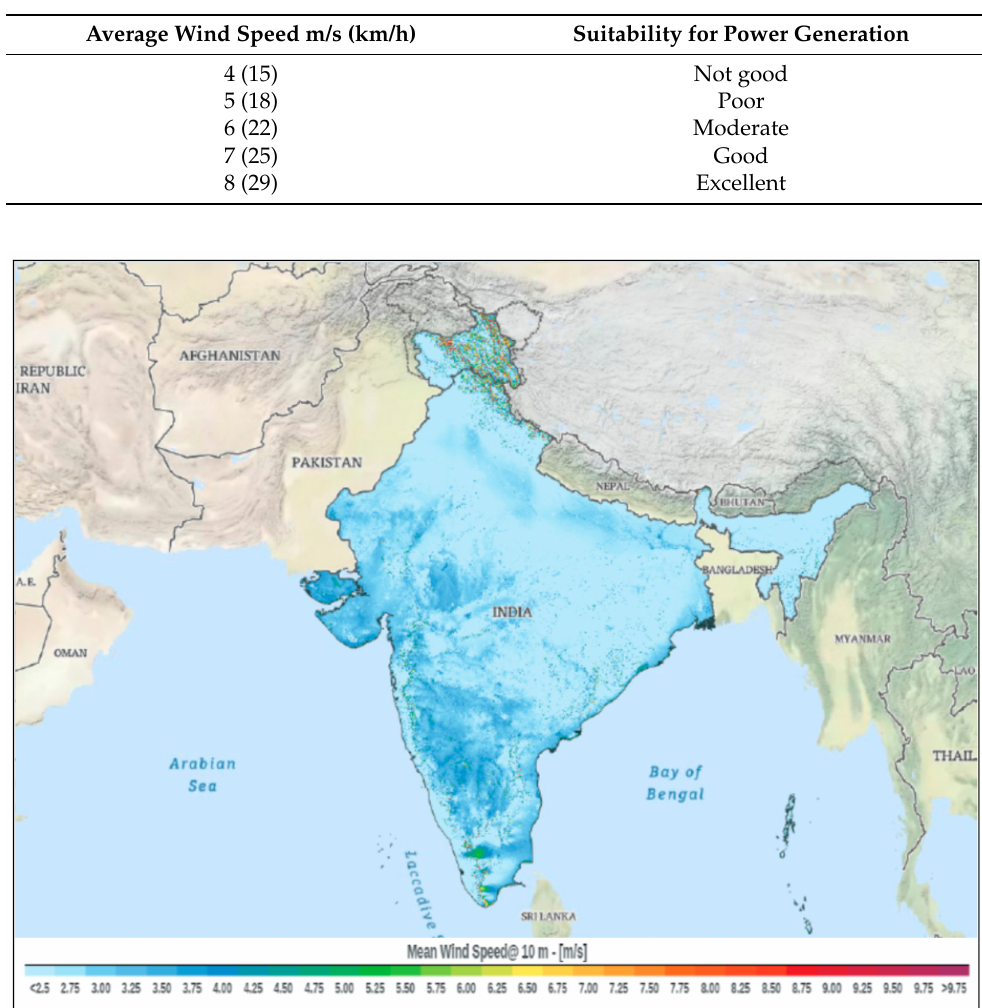
Figure 1. Wind map of India (10 m) from the Global Wind Atlas